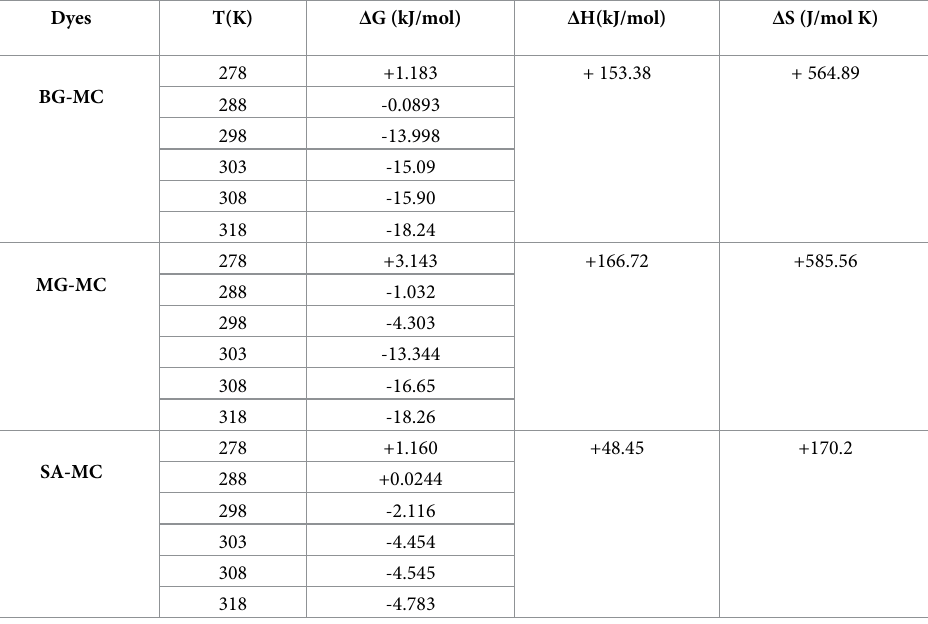
Table 2. Thermodynamic parameters for the adsorption of BG, MG, and SA dye molecules onto the